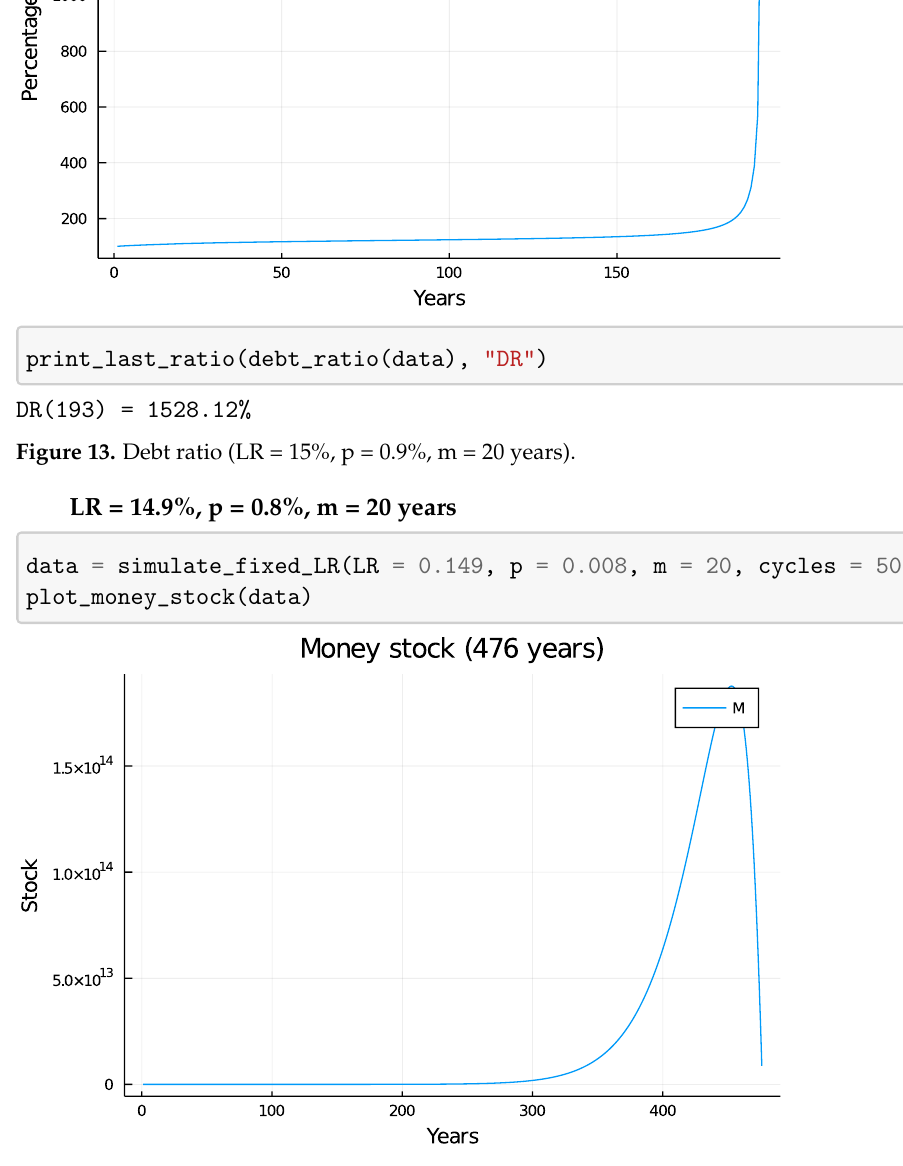
Figure 14. Money stock (LR = 14.9%, p = 0.8%, m = 20